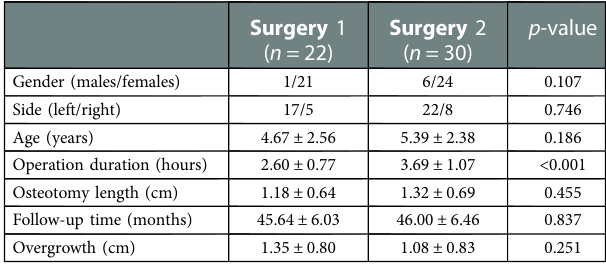
TABLE 3 Comparison of variables between the two groups of children who underwent surgery 1 and surgery 2.